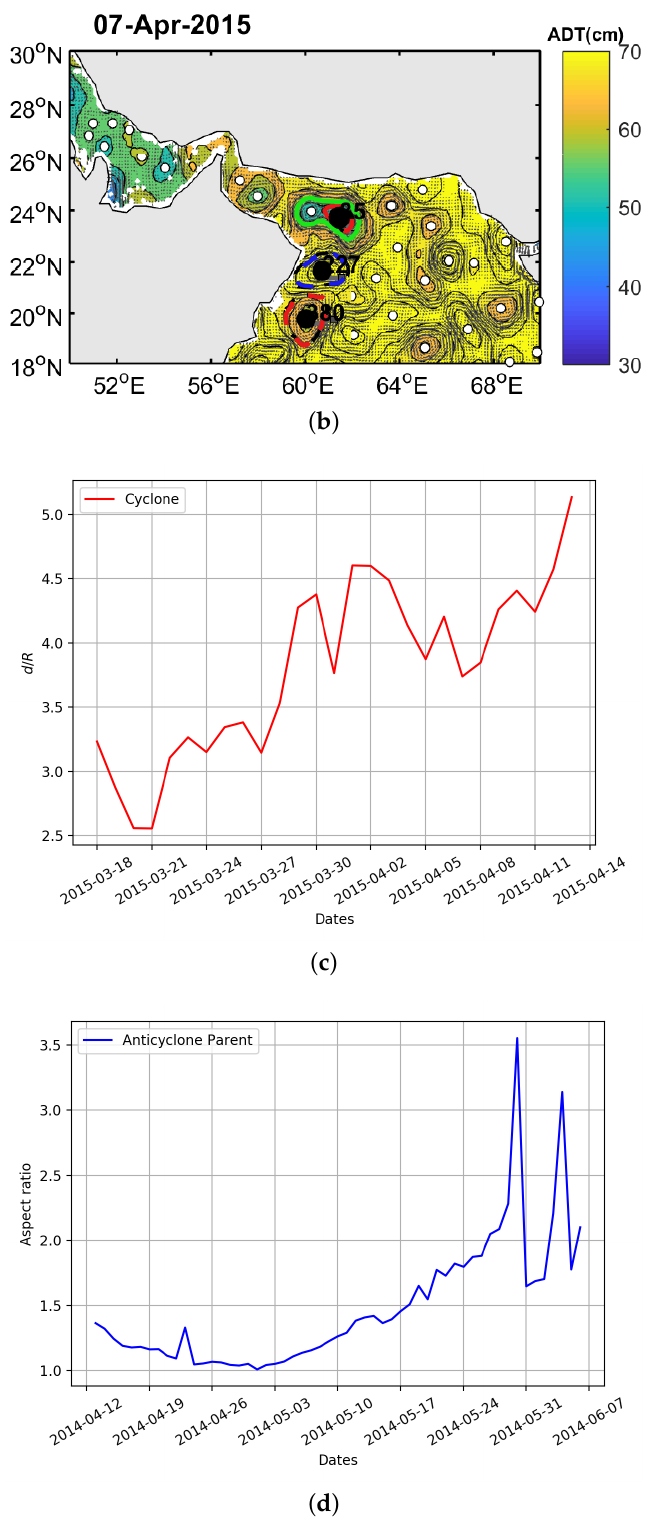
Figure 3. ( a ) Sea surface height map showing the elongation of the Ras al Hadd anticyclone (green contour, eddy 227) under the influence of cyclone 35, on 5 June 2014; ( b ) sea surface height map showing the merging of the Ras al Hadd cyclone with eddy 35 on 7 April 2015 (green contour); ( c ) ratio of mutual distance to the mean radius of the two cyclones for the merging event; and ( d ) aspect ratio of the anticyclone for the splitting